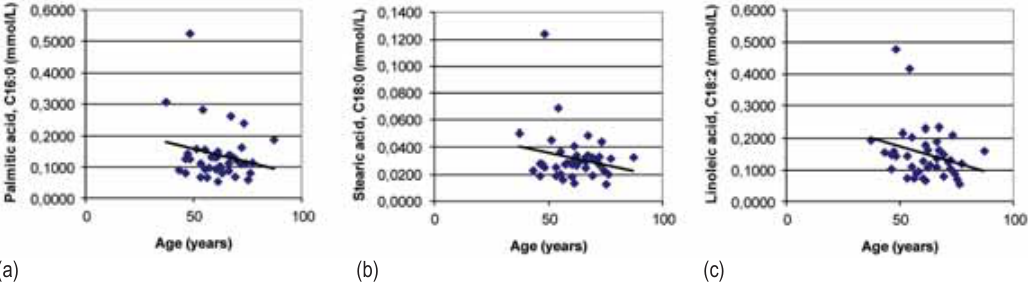
FIGURE 4. The correlation between age and plasma levels of palmitic acid (a), stearic acid (b), linoleic acid (c) in the patients with Type 2 diabetes mellitus. Spearman´s rho correlation coef fi cients ρ =0.040, ρ =0.021, and ρ = -0.135, respectively.